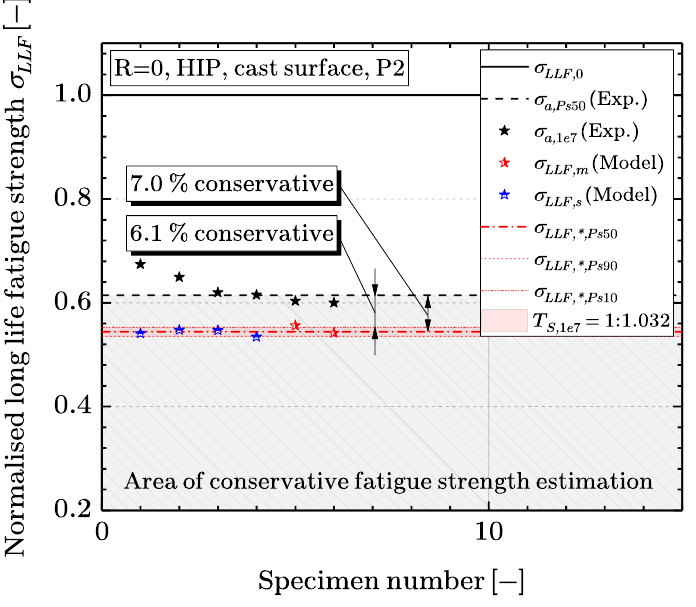
Figure 10. Long life fatigue strength assessment result of the validation series HIP